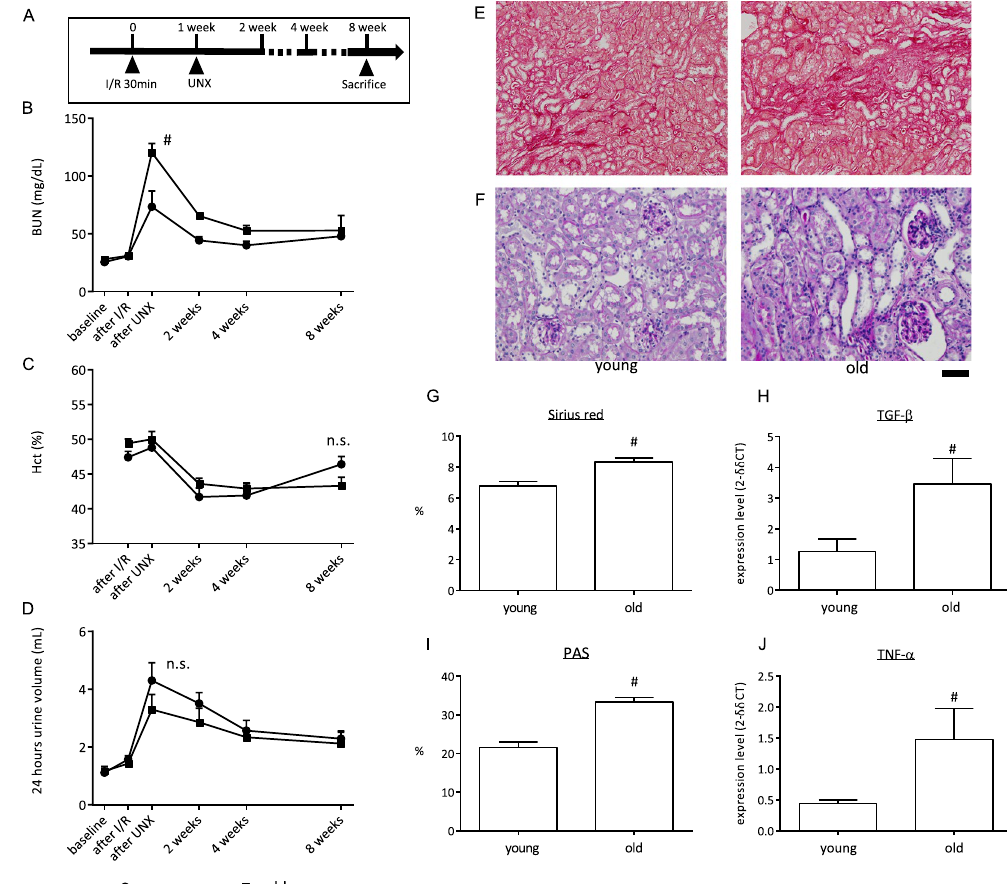
Figure 3. Assessment of influence by aging. ( A ) Schematic of the experiment schedule. ( B–D ) Time course changes in BUN ( B ), haematocrit (Hct) ( C ), and 24-h urine volume ( D ) in the young and old mice that were subjected to 30-min ischaemia/reperfusion (I/R) and then uninephrectomy (UNX) 1 week later (n = 6). Blood sampling for the “after I/R” or “UNX” was performed at 24 hours after each procedure. ( E , F ) Representative images of Sirius red and PAS staining in each group. Scale bar = 100 µ m for Sirius red and 50 µ m for PAS. ( G ) Semi-quantitative analysis of Sirius red staining in the renal cortex. ( H ) Quantification of TGF- β expression in the kidney. ( I ) Semi-quantitative analysis of PAS staining in the renal cortex. ( J ) Quantification of TNF- α expression in the kidney. # p < 0.05 vs. young group; ns, no